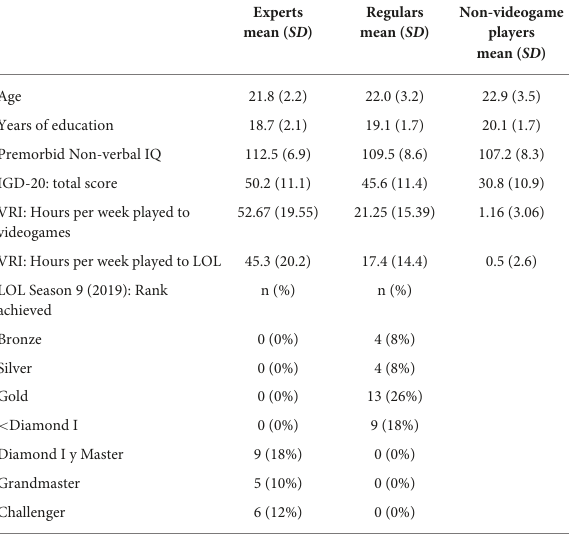
TABLE 2 Sociodemographic and game features among